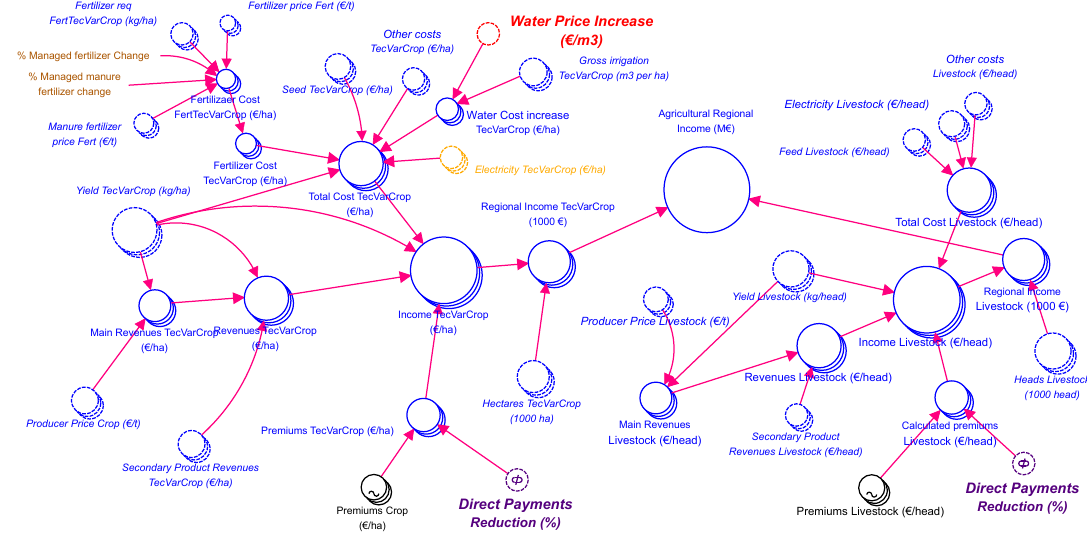
Figure 6. Food sub-sector representation in the system dynamics model. Source: our own elaboration.